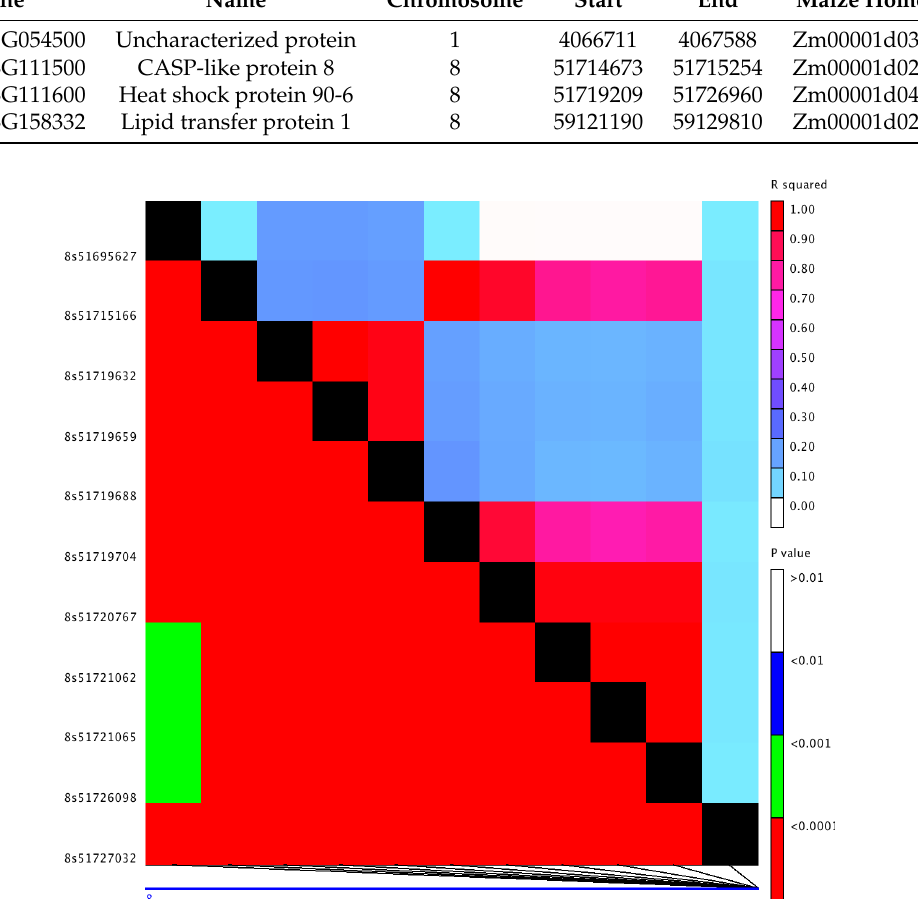
Figure 2. Linkage disequilibrium between single nucleotide polymorphisms (SNPs) from associated region ∼ 52 Mb of chromosome 8: R-squared values are above the diagonal, and associated p -values are below the diagonal. The left y-axis label shows the position of the SNPs with 8s corresponding to